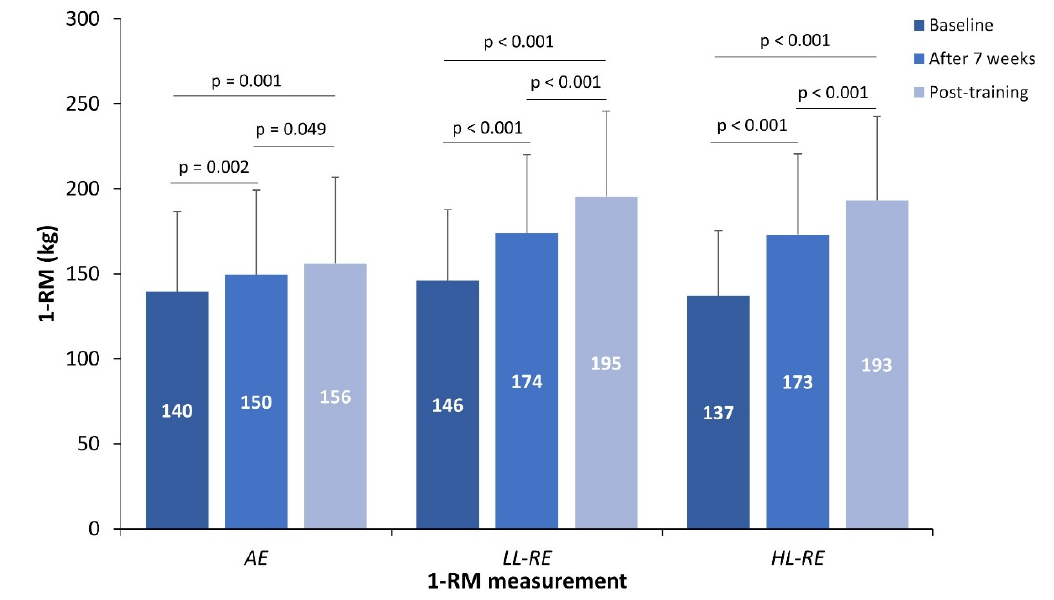
Figure 2. The 1-RM at baseline, after seven weeks and post-training.